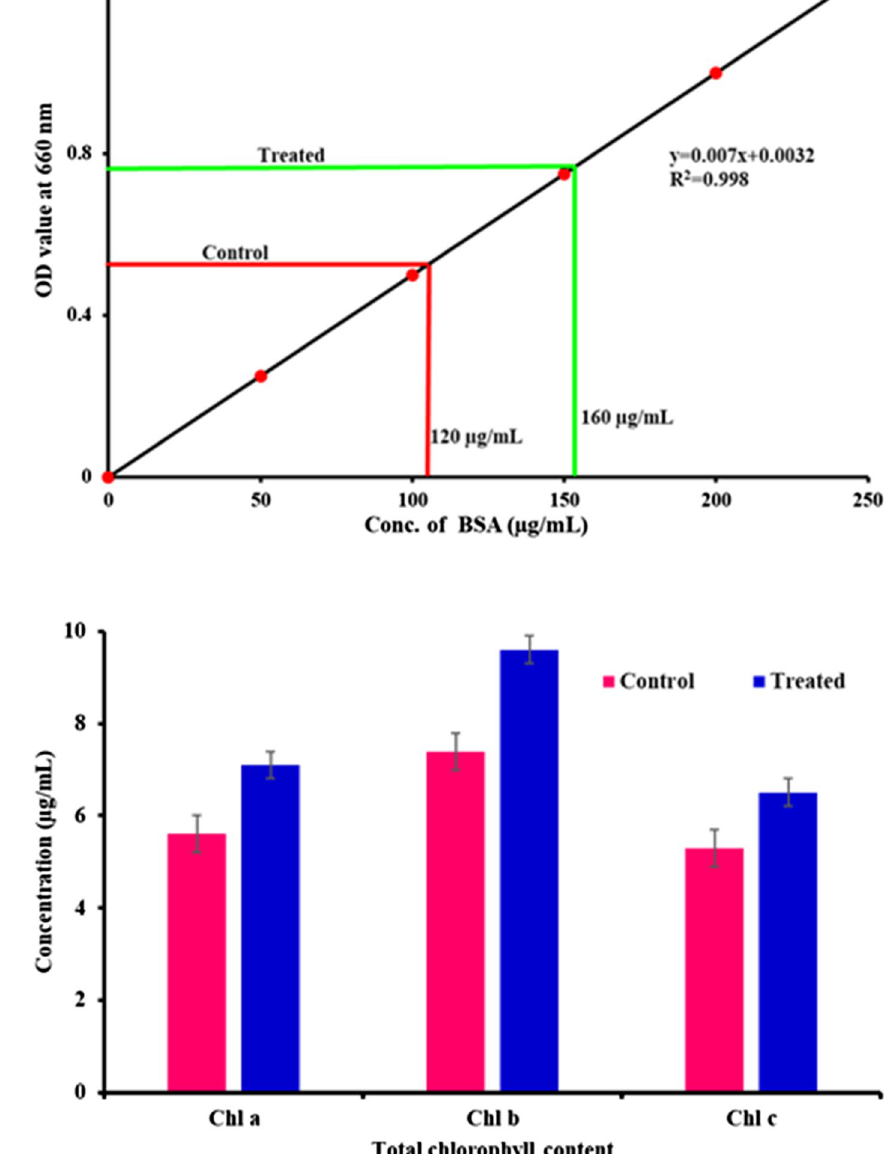
Fig. 5 Estimation of protein from microalgae Chlorella sp.